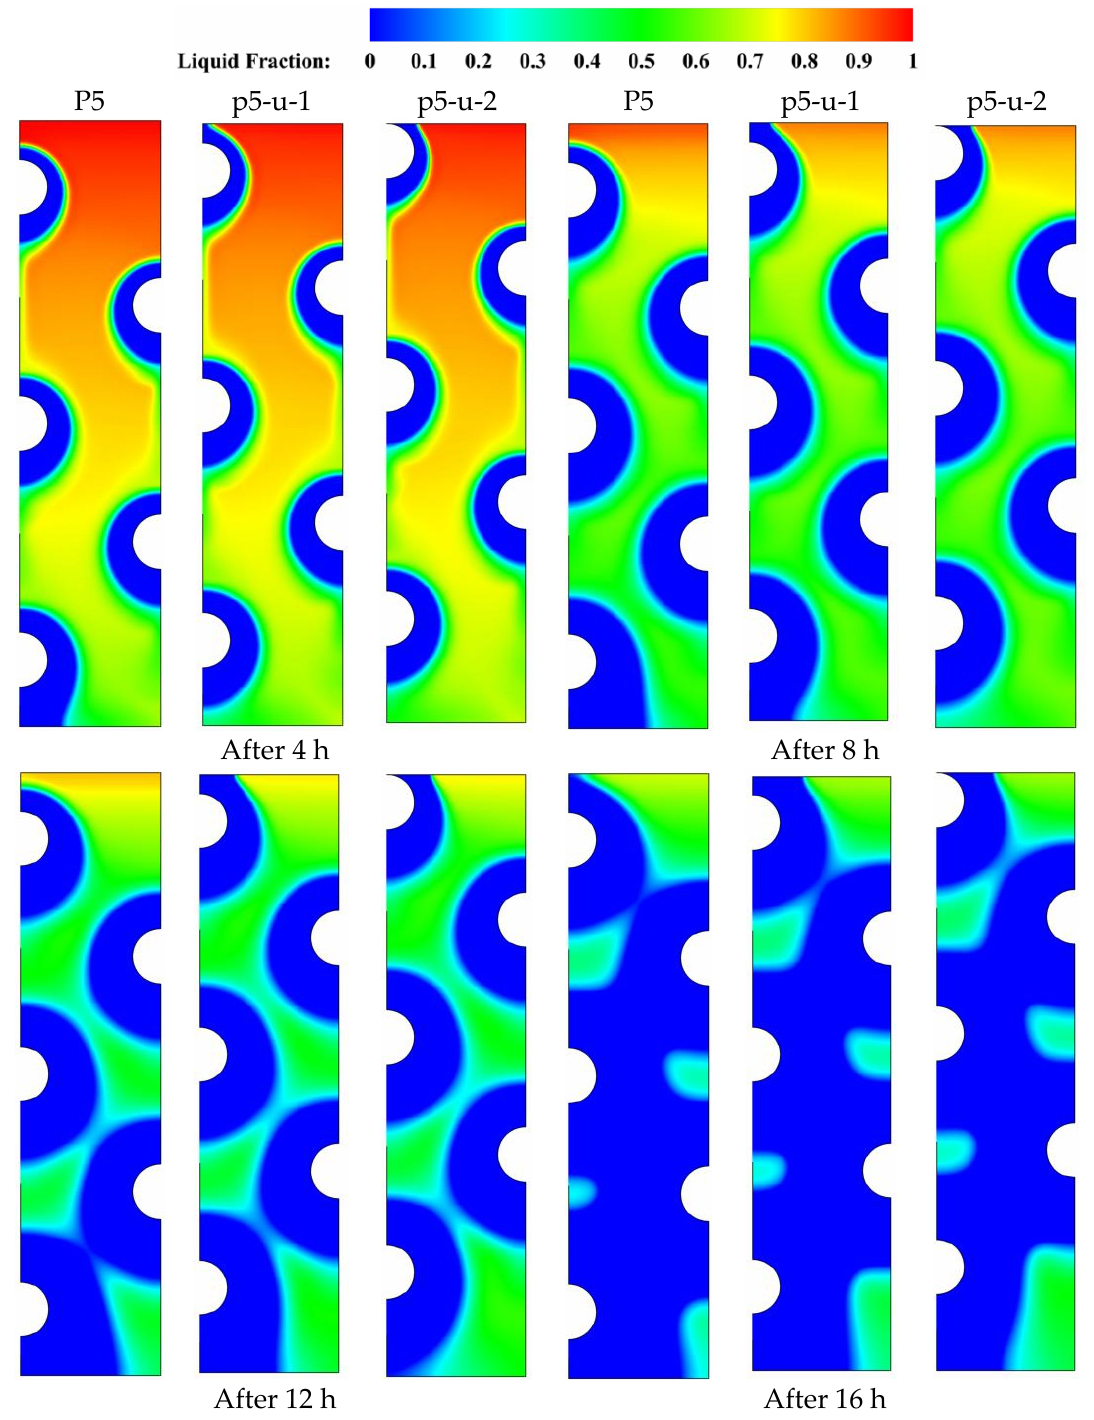
Figure 8. Contours of the PCM liquid-fraction progression for three different HTF-tube arrangements of P5, p5-u-1, and p5-u-2 over multiple solidification durations.